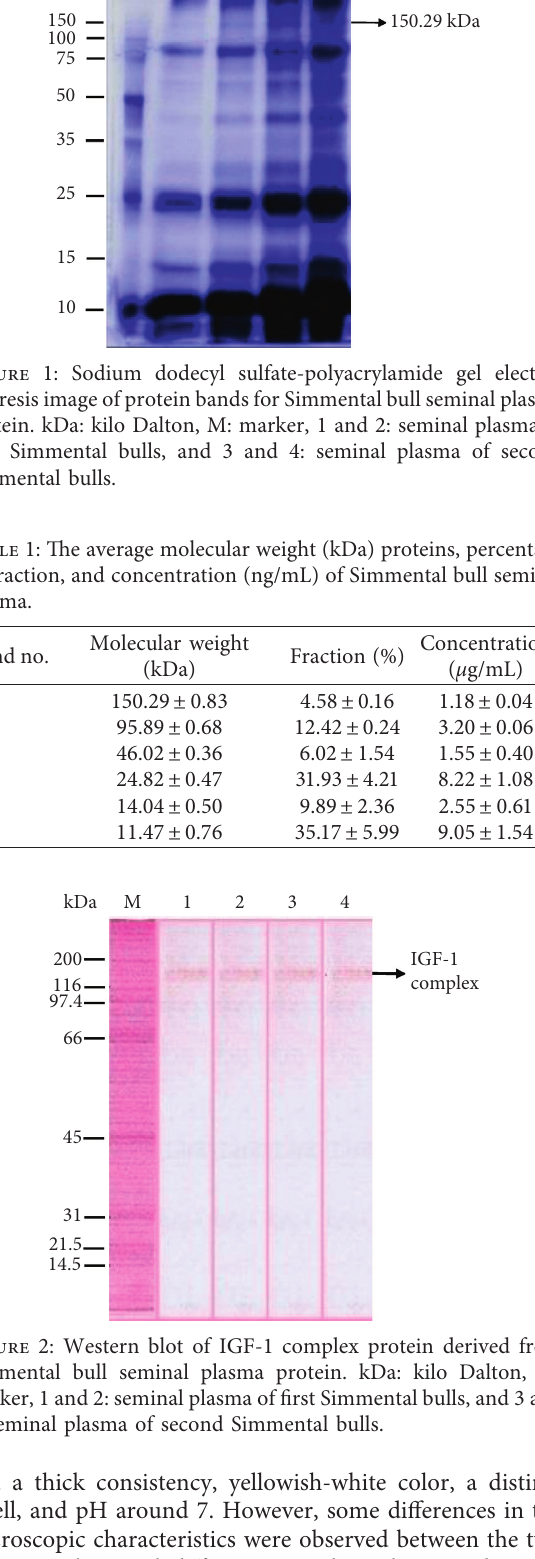
Table 2: Characteristics of Simmental bull and Kacang